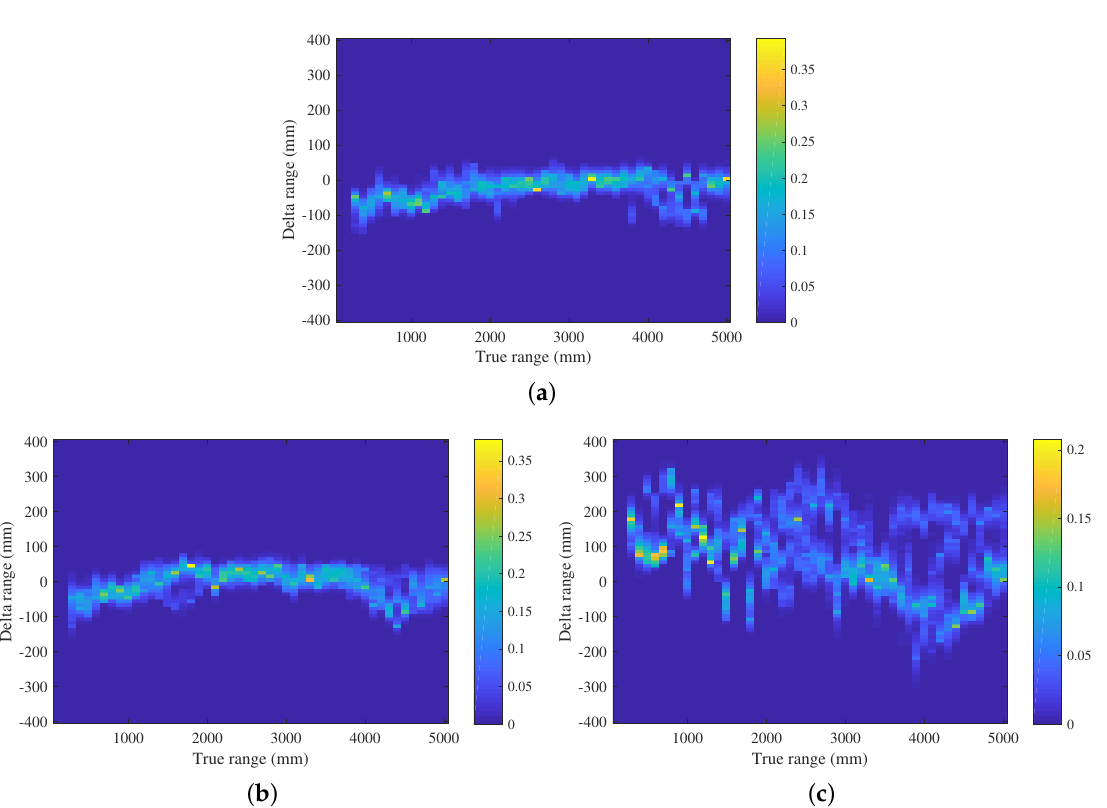
Figure 1. The time of arrival (TOA) sensor model built for different ultra-wideband (UWB) signal propagation cases, i.e., ( a ) line-of-sight ( LOS ); ( b ) non-line-of-sight with wood obstruction ( NLOS W ); and ( c ) non-line-of-sight with metal obstruction ( NLOS M ) cases using 132,651, 196,063, and 200,659 measurement samples,